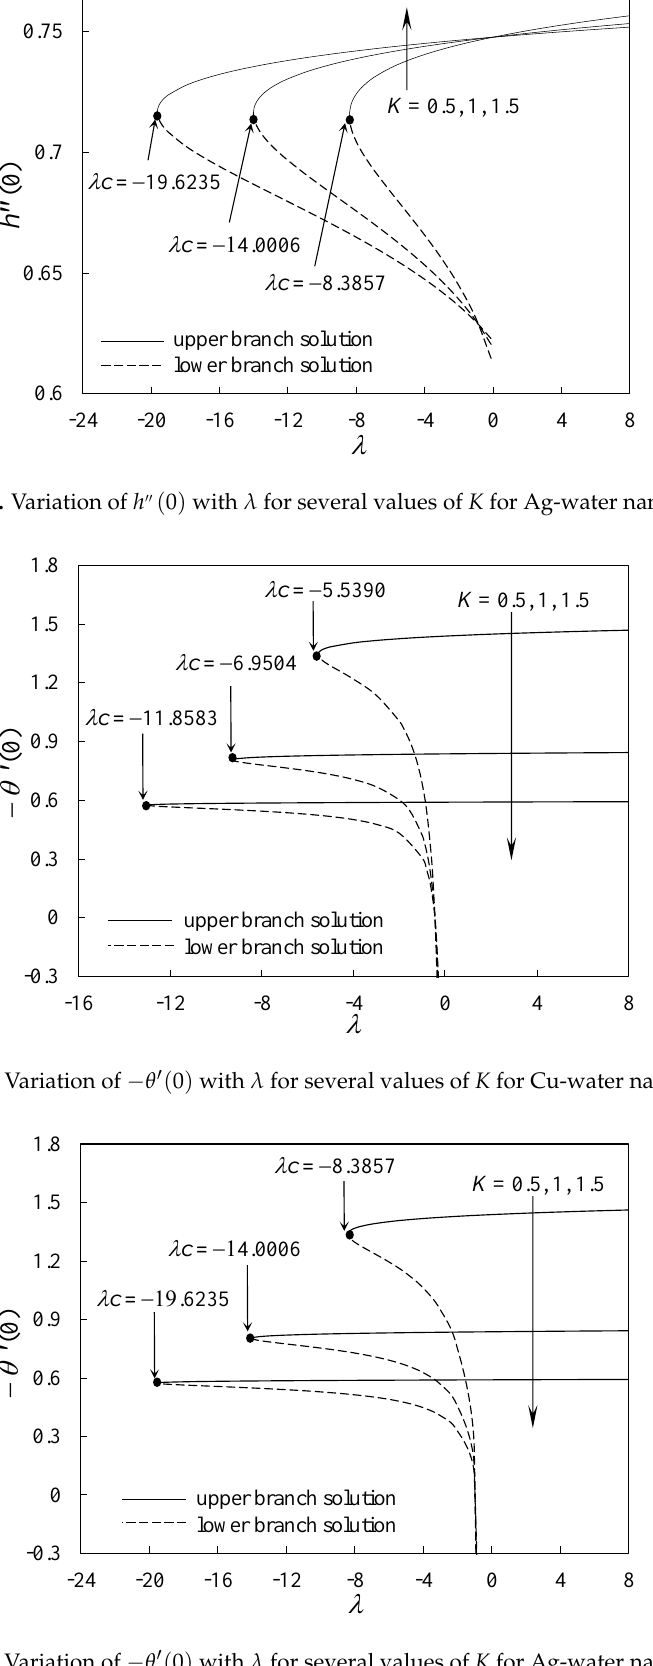
Figure 13. Variation of